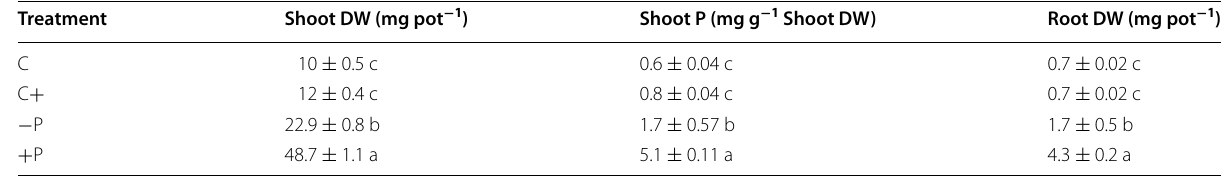
Values are means of four replicates